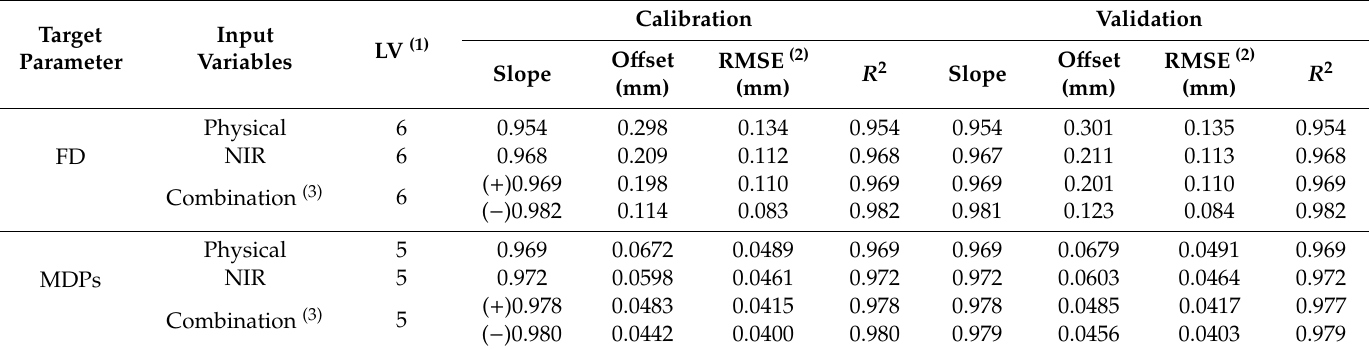
Table 5. Calibration and cross-validation results of tableting process parameters based on the various input